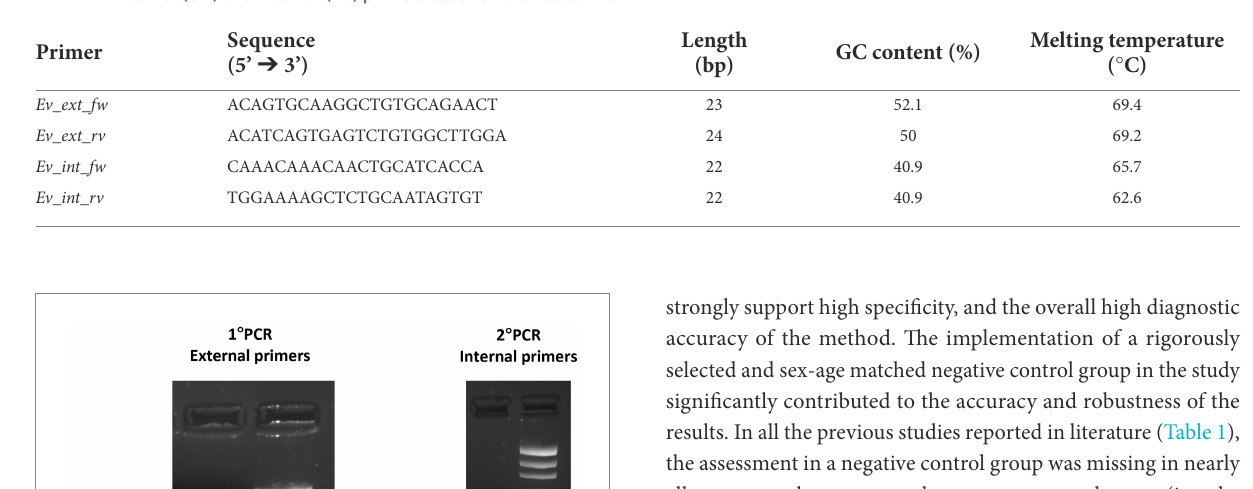
TABLE 2 External (ext) and internal (int) primers used for the nested PCR.